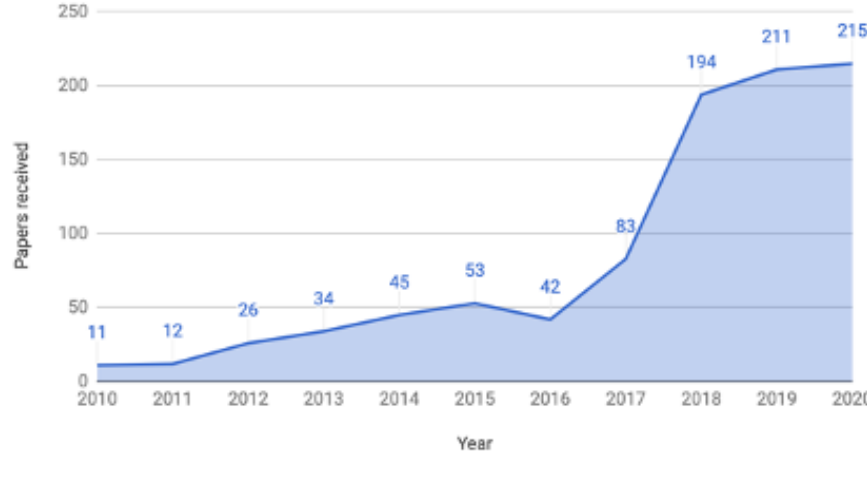
Figure 1. JOTSE's